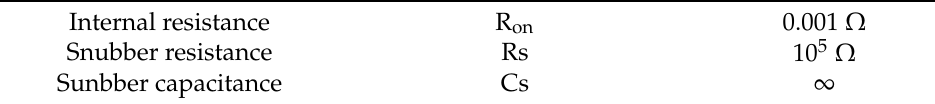
Table 2. Main parameters of the IGBT.